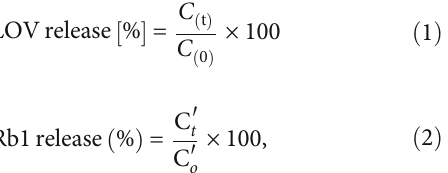
Figure 1: FTIR spectra of AC82L10R x composite fi Table 1: Position of peaks for main characteristic groups in AC82L10R x composite fi lms.